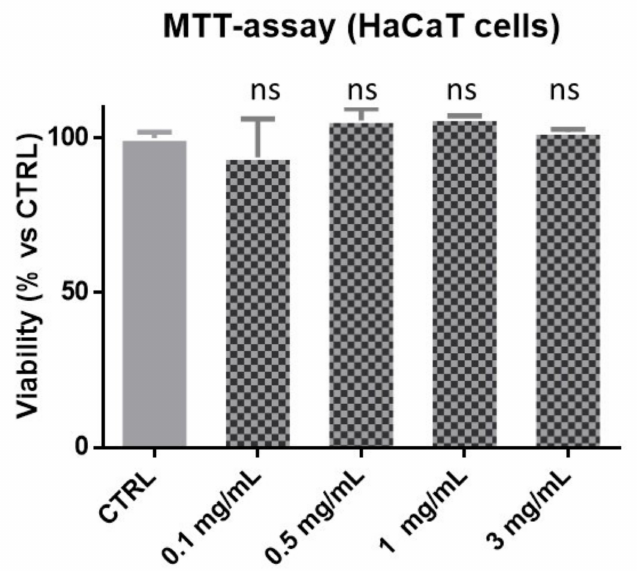
Figure 2. CSE effect on HaCaT cells viability by MTT test. Results shown are the mean ± SD of three determinations. Data were analyzed by one-way ANOVA followed by Tukey’s multiple comparison and data considered significant different p value < 0.05. ns = not significant vs. control